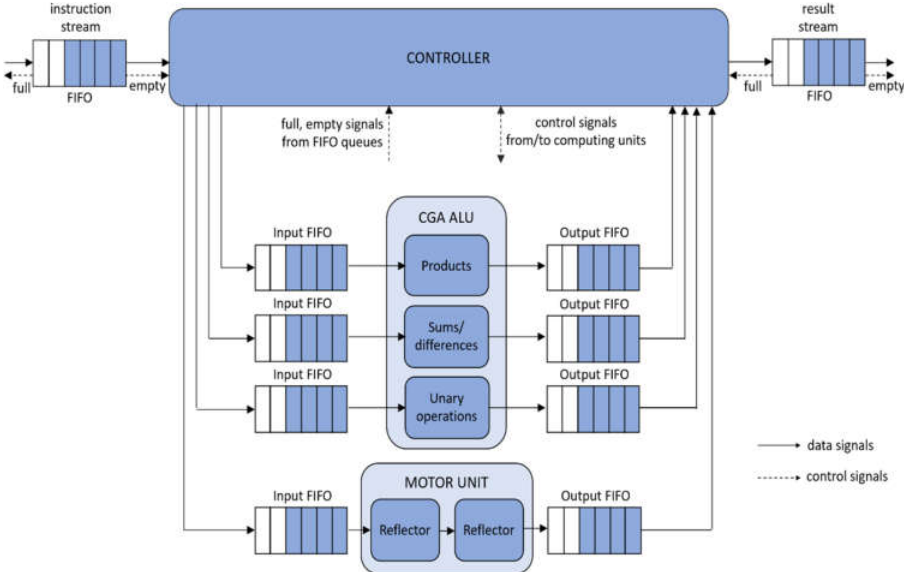
Figure 1. CGA coprocessor block diagram. The controller unit fetches the instructions from the instruction FIFO, decodes the opcodes, distributes the instructions on the four parallel pipelines (the products unit, the sums/differences unit, and the unary operations unit of the CGA ALU, and the motor unit), collects the results from the pipelines, and forwards them to the result FIFO.